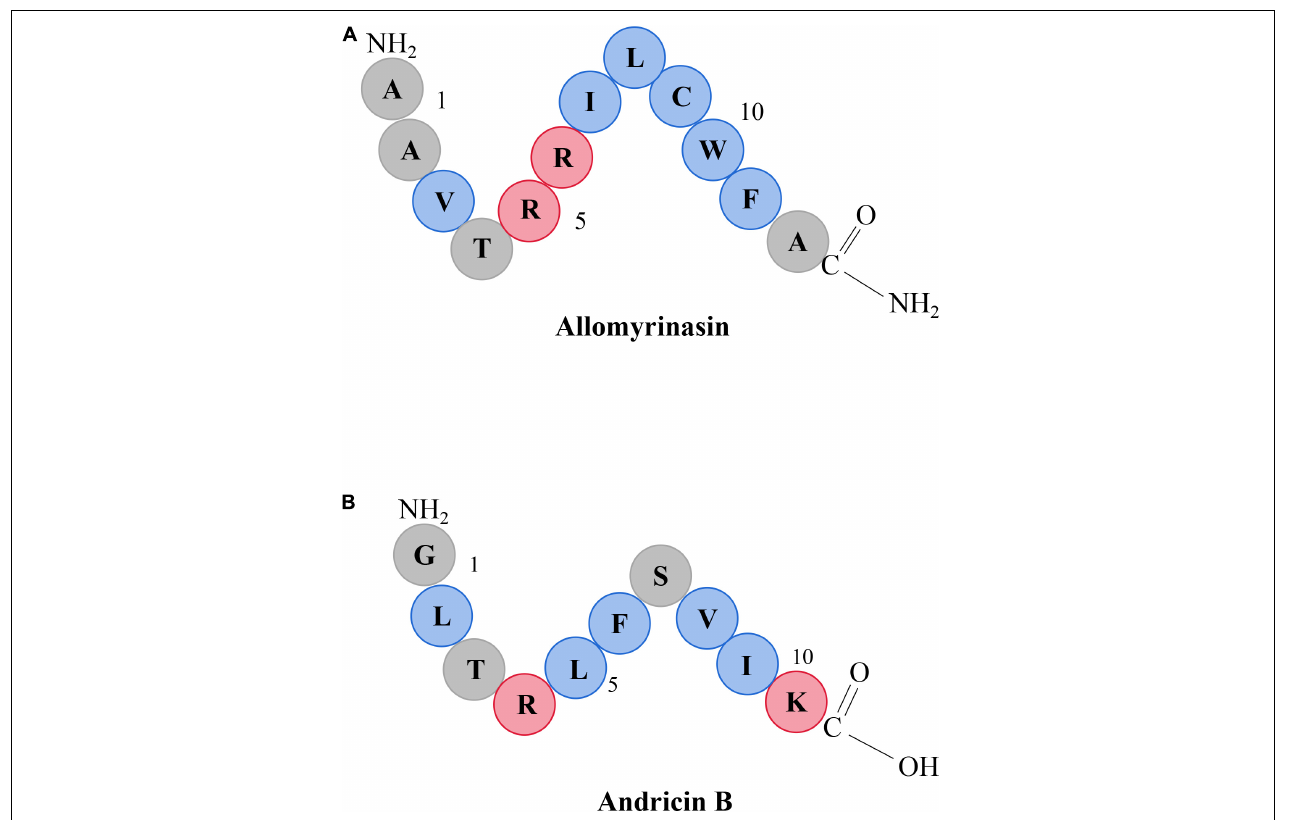
FIGURE 1 | Schematic representation of allomyrinasin (A) and andricin B (B) . Hydrophobic residues are in blue, while those residues with a net positive charge are in